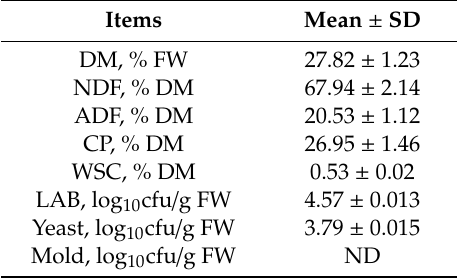
Table 1. Chemical compositions and microbial populations of wet brewers grains before ensiling. Items